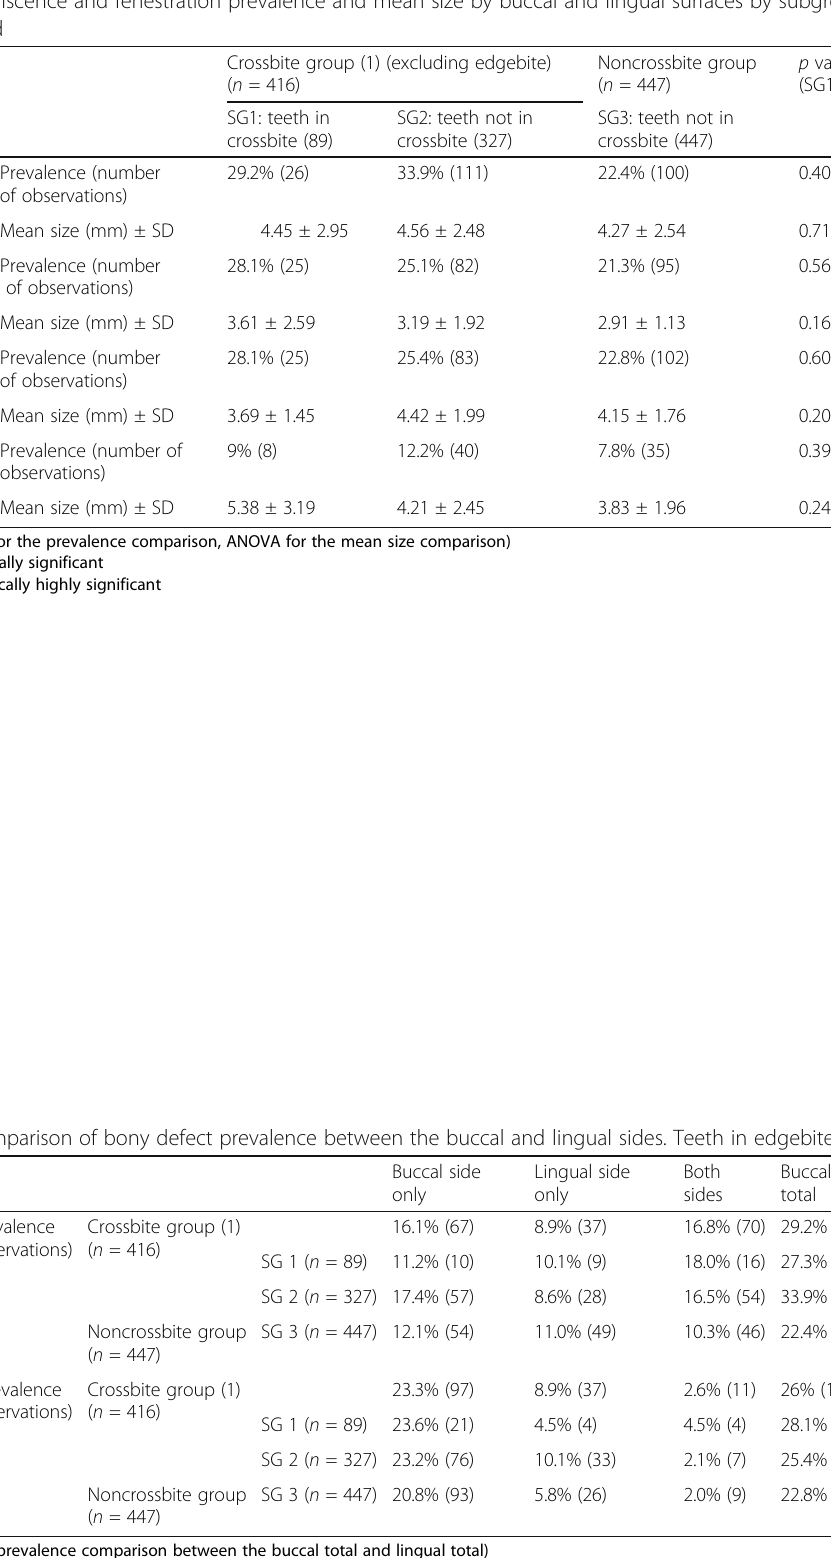
Crossbite group (1) ( n =